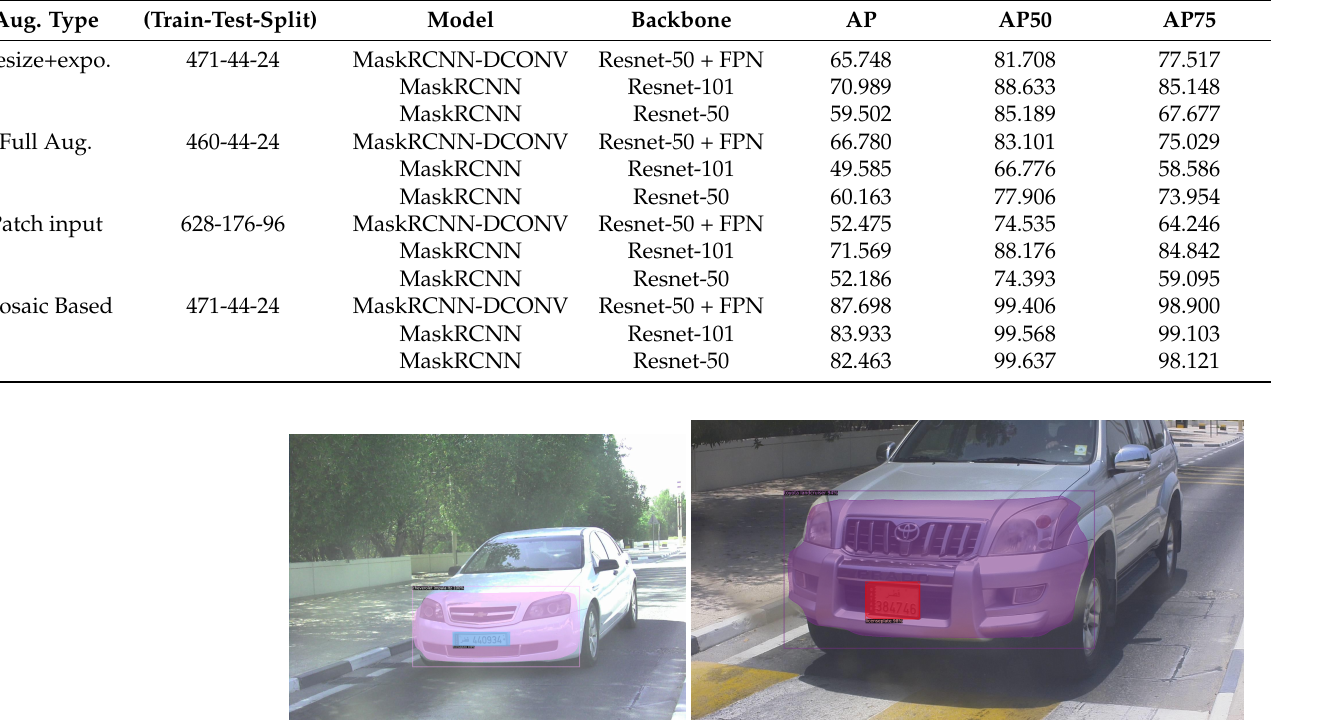
Table 3. Ablation study on data augmentation.